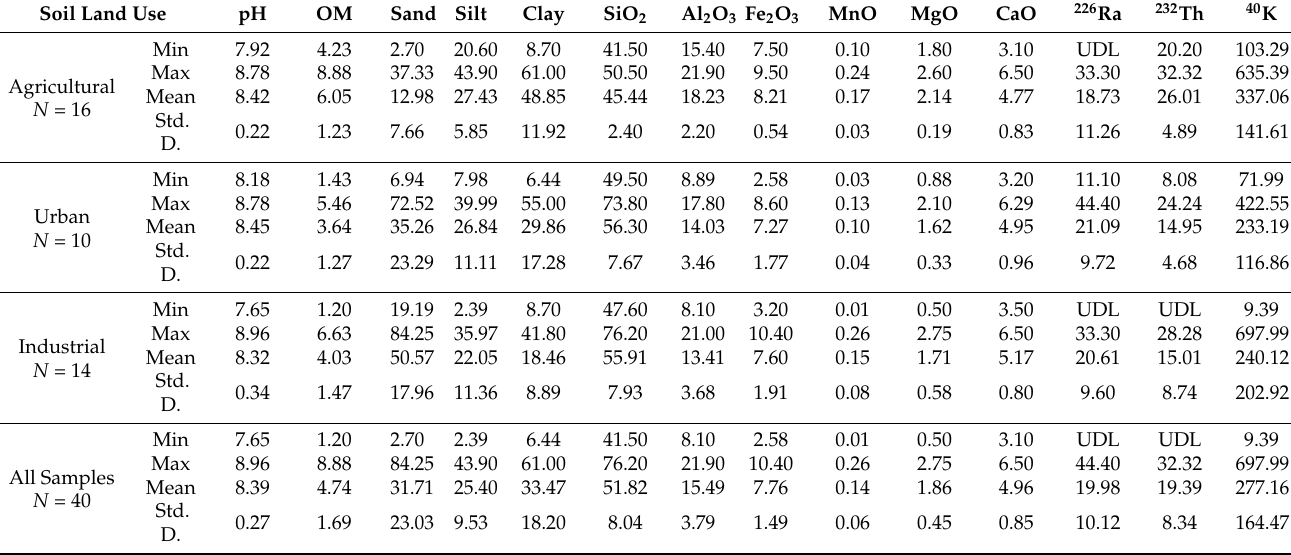
Table 2. Descriptive statistics of soil physicochemical parameters and oxides (%) and measured radionuclides (Bq Kg − 1 ) in different land-use soil samples.